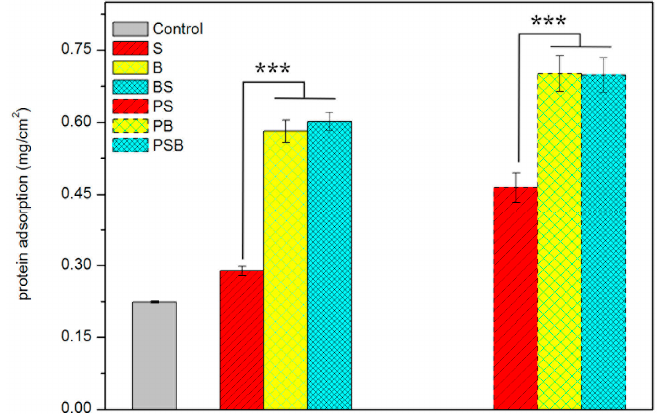
Figure 4. Protein adsorption ability analysis of MC3T3-E1 cells on different surface